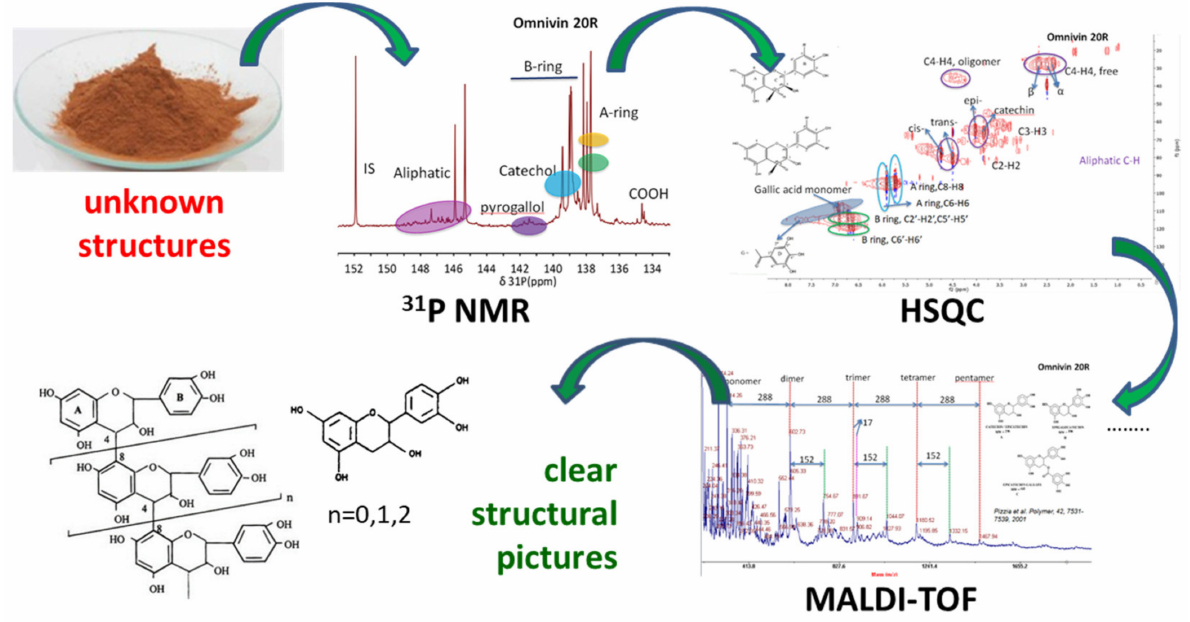
Figure 1. Analytical toolbox and workflow for elucidating structural features of commercially available